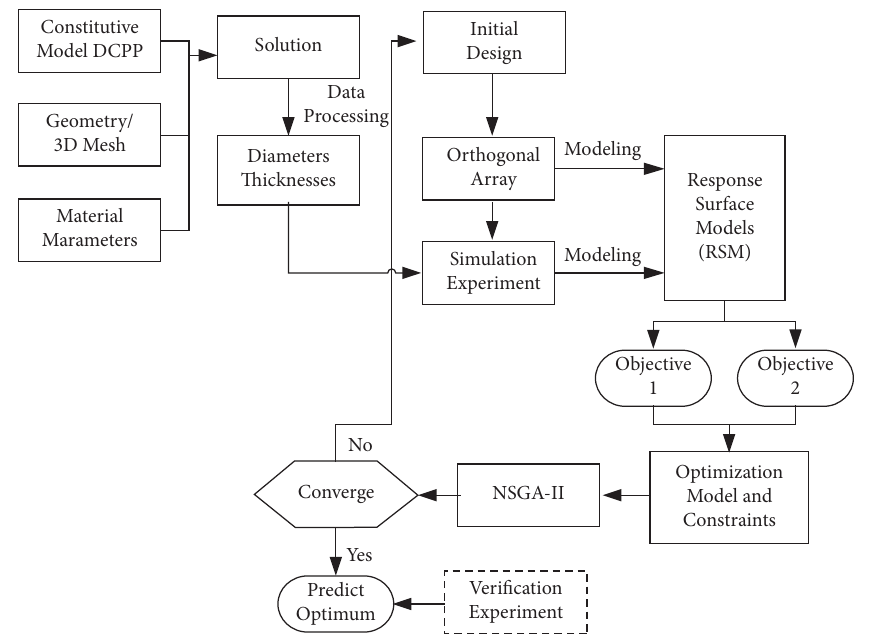
Figure 1: Te optimization fowchart of the extrusion process parameter optimization